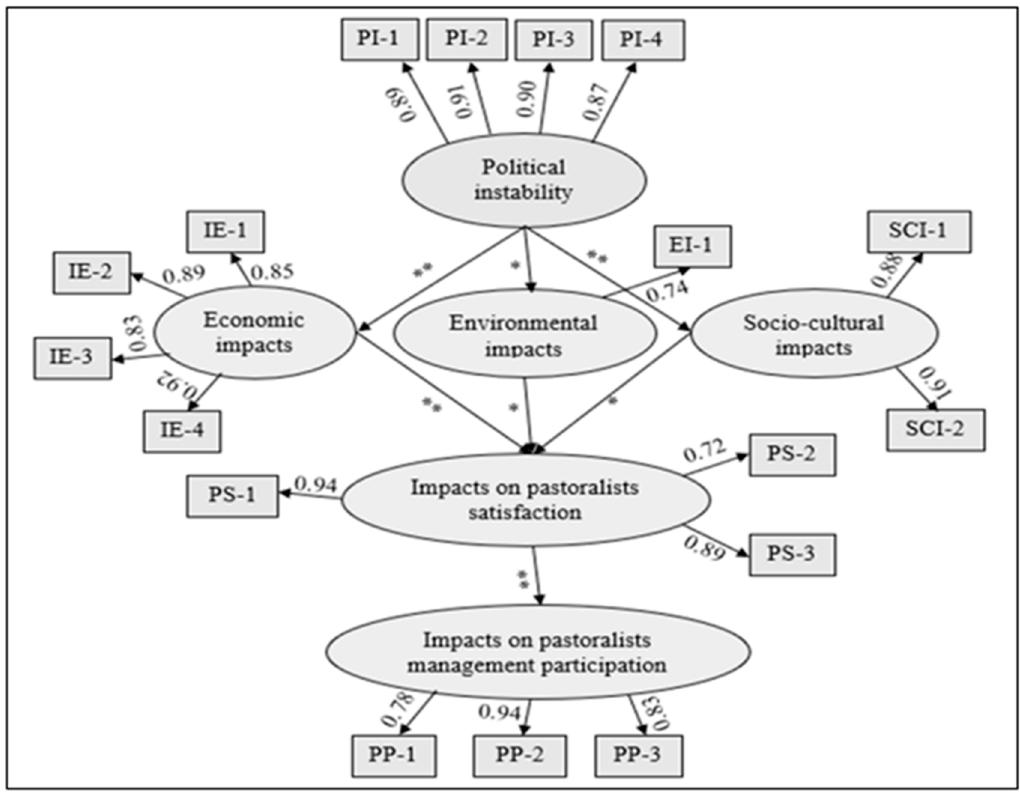
Figure 5. The model of political instability effects on sustainable rangeland management. ** Statistically significant at p < 0.001, * statistically significant at p < 0.05 (the model was modified from [30]).